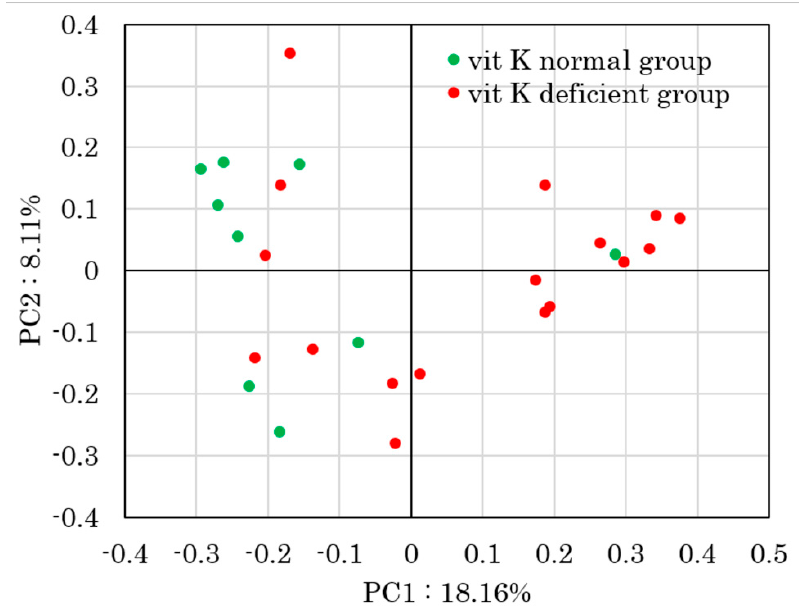
Figure 3. Principal coordinates analysis (PCoA) derived from unweighted UniFrac distances. Comparison between vitamin K-deficient group and vitamin K-normal group with PERMANOVA showed a significant difference in unweighted UniFrac distances ( p = 0.013). vit K, vitamin K; PC, principal coordinate.